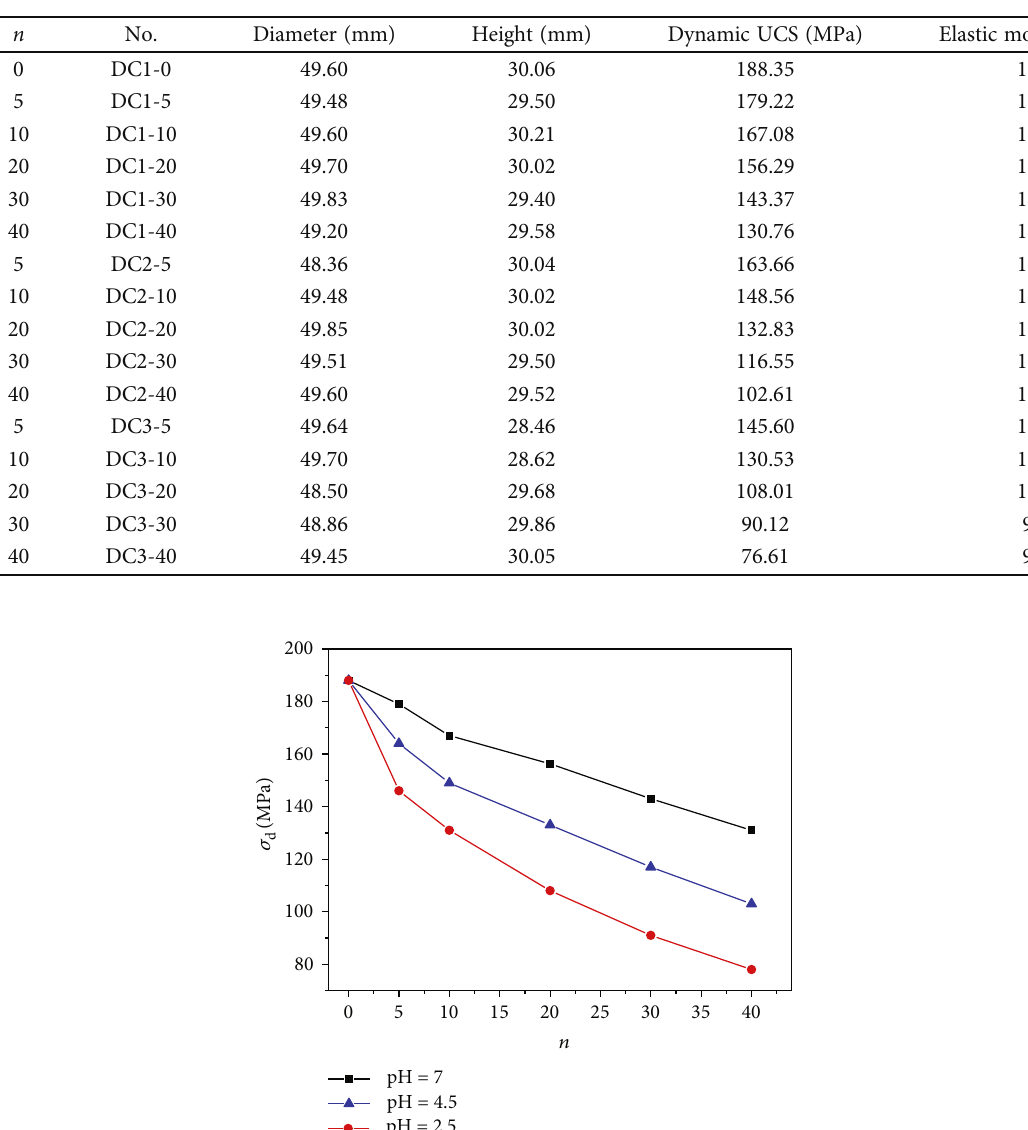
Table 1: SHPB test results of red sandstone in di ff erent environments.